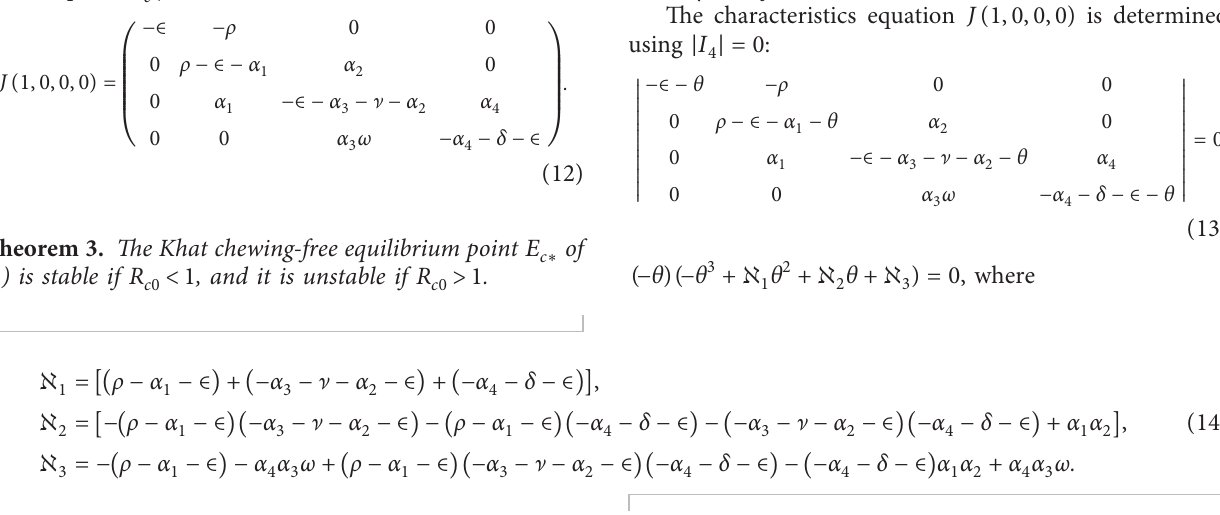
table. Using the above definition, the system is stable; this implies that R c eigenvalue if R c If at least one of ℵ there is a sign change in the first column of the Routh–Herwitz table. Then, the system is unstable; this implies that R c